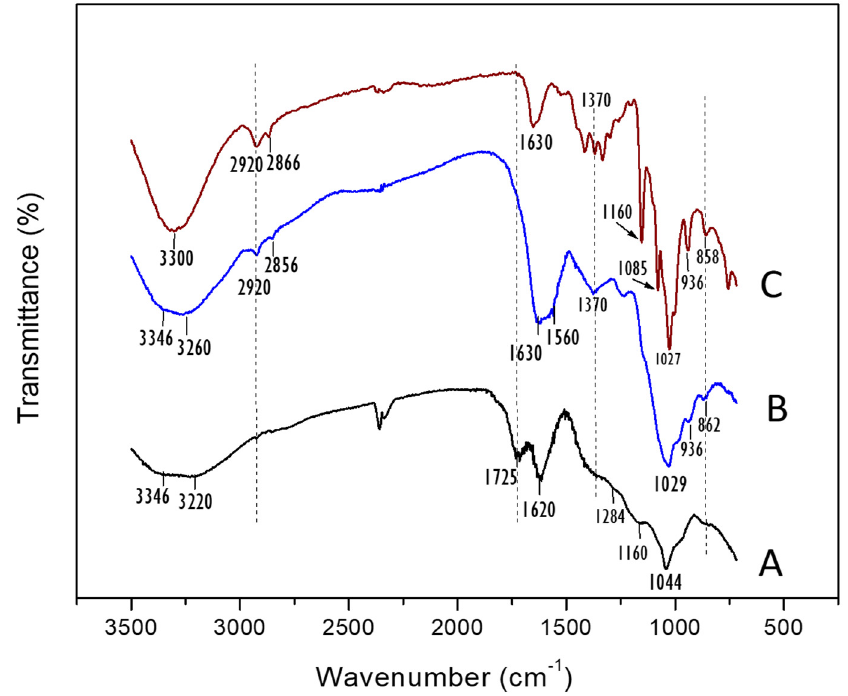
Figure 2. ATR − FTIR spectra of GO ( A ), CD1 − GO ( B ), and CD1 ( C ). Figure 2. ATR-FTIR spectra of GO ( A ), CD1-GO ( B ), and CD1 ( C